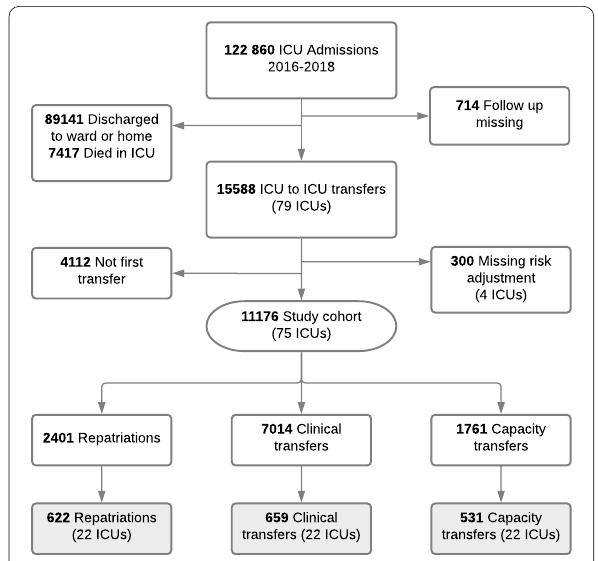
Fig. 1 Patient flow diagram. The primary analysis included 11,176 transfers from 75 ICUs (bold boxes). A secondary analysis was based on 1812 transfers from 22 referring ICUs (grey boxes) where patients had a SOFA score recorded at discharge from the referring